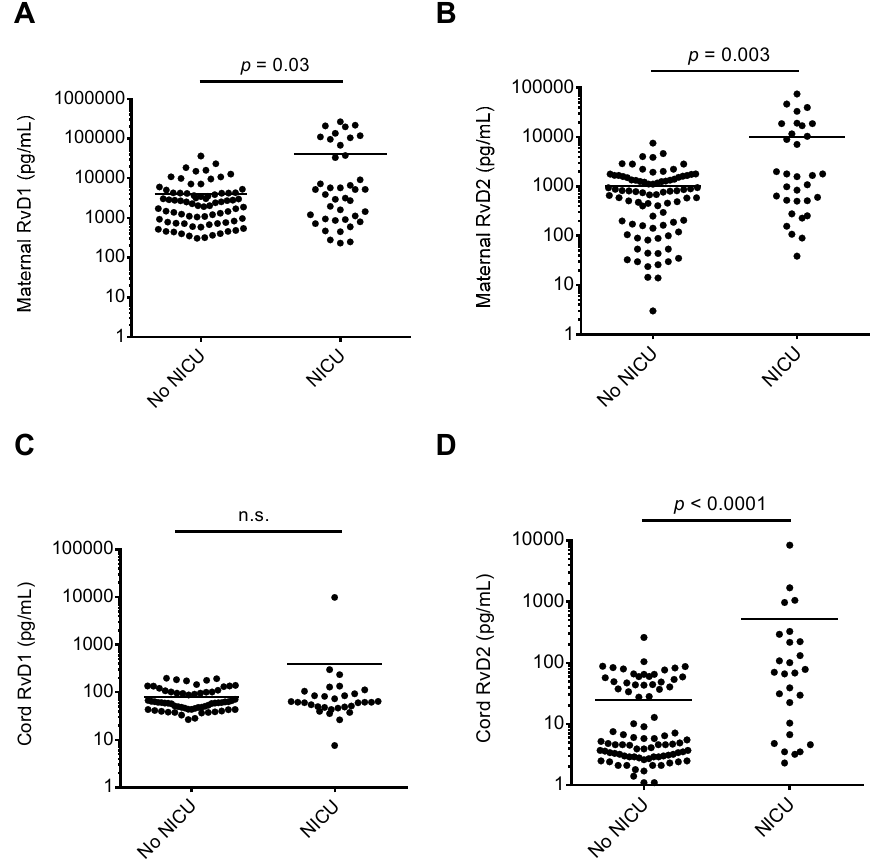
Figure 2. Comparison of maternal and cord blood plasma RvD1 and RvD2 levels and infant NICU admission at birth. Samples were stratified based on infant NICU admission at birth (yes/no) and maternal and cord blood plasma RvD1 and RvD2 levels were compared. ( A ) Maternal RvD1 levels; ( B ) maternal RvD2 levels; ( C ) cord RvD1 levels; ( D ) cord RvD2 levels. n.s.: no significant difference.